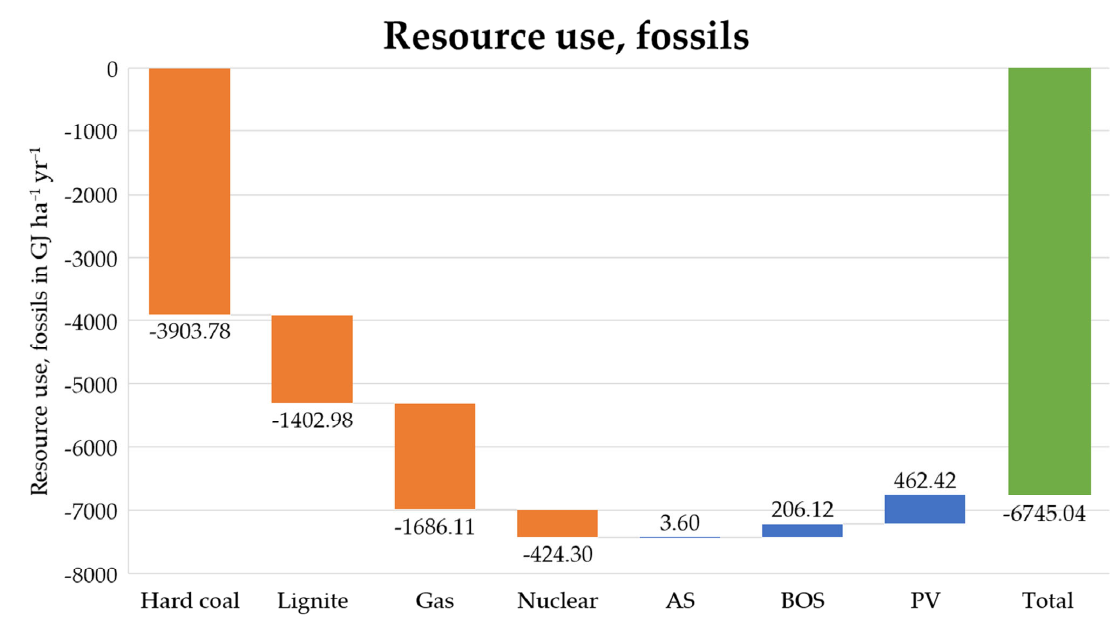
Figure 5. Environmental impact of the change of 1 ha single-use agriculture to an overhead AVS in Germany in the category resource use, fossils per year (AS: agricultural system, BOS: balance of system, PV: PV modules).